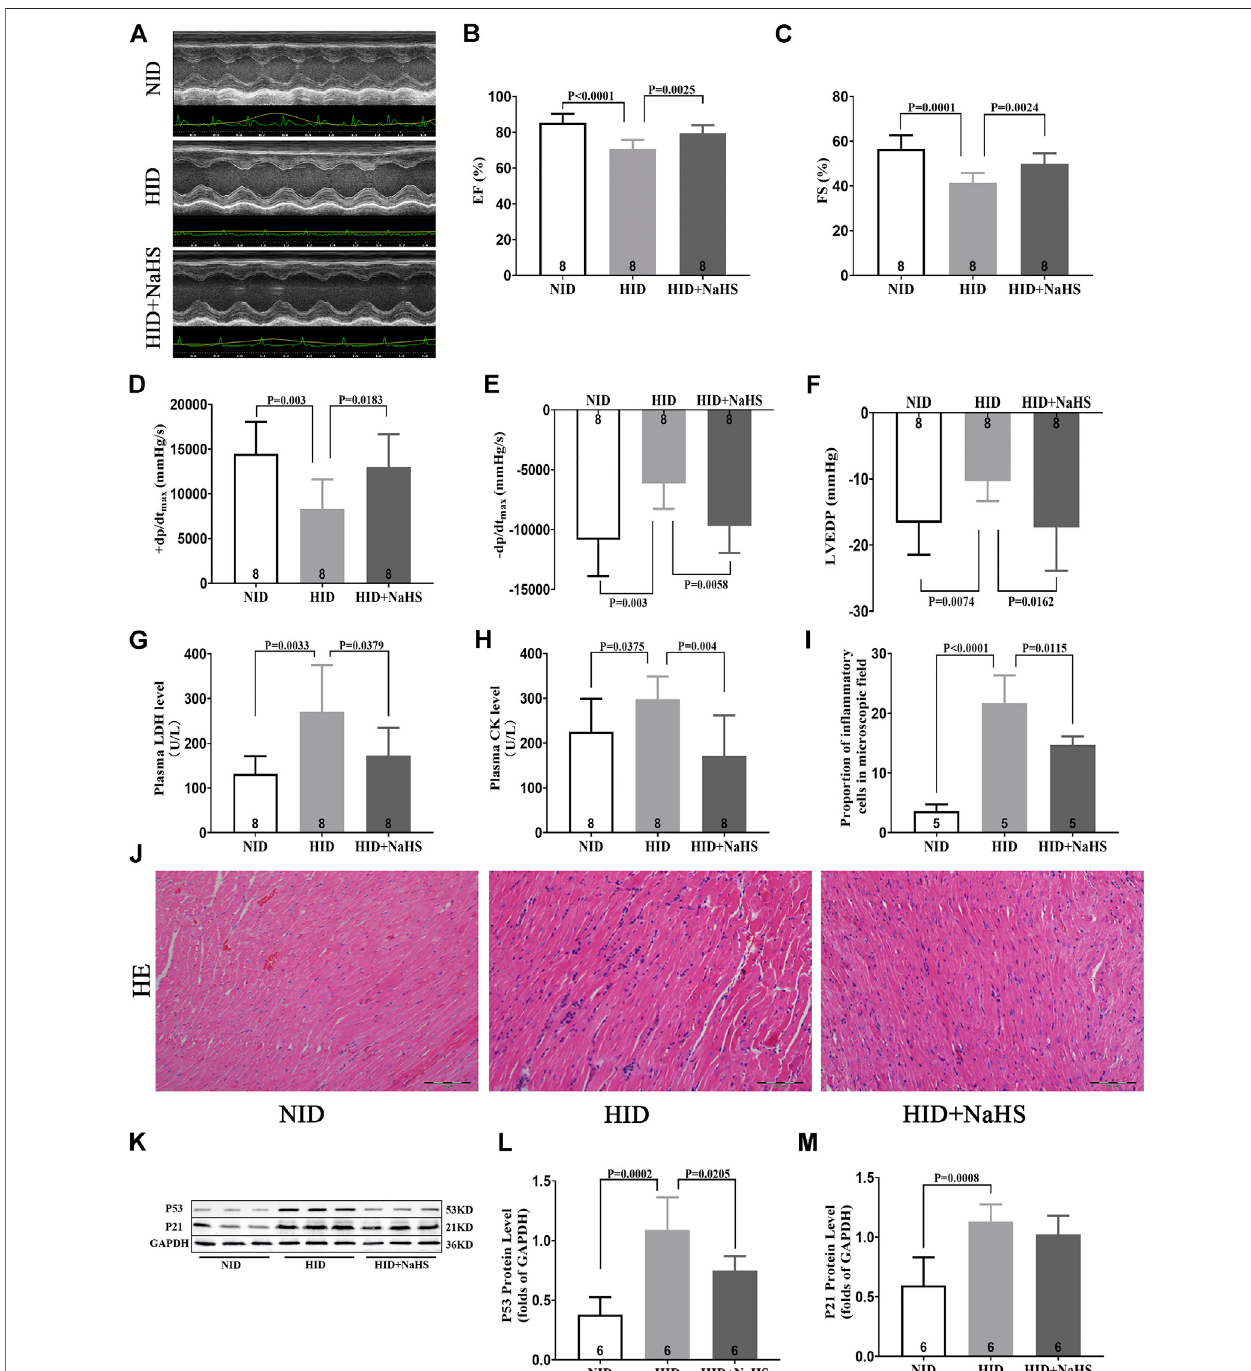
FIGURE8| H 2 Salleviatedmyocardialinjuryand improved cardiac functioninratsfed withHID. (A) Representativeimages ofM-mode byechocardiographyin HID rats. (B) Values of EF (%) in HID rats. (C) Values of FS (%) in HID rats. (D) Values of +dp/dt max in HID rats. (E) Values of − dp/dt max in HID rats. (F) Values of LVEDP in HID rats. (G) Levels of plasma LDH in HID rats. (H) Levels of plasma CK in HID rats. (I) Quantitative data on in fl ammatory cells in the microscopic fi eld (%) of HID rats. (J) Representative HE-stained myocardial sections of HID rats. (K) Representative Western blots for P53 and P21 expressions in myocardial tissues of HID rats. GAPDH was used as the internal control. (L) Quantitative analysis for the P53 expression in the myocardial tissue of HID rats. (M) Quantitative analysis for the P21 expression in the myocardial tissue of HID rats. Results are means ± SEM. A p -value of < 0.05 was considered signi fi cant.